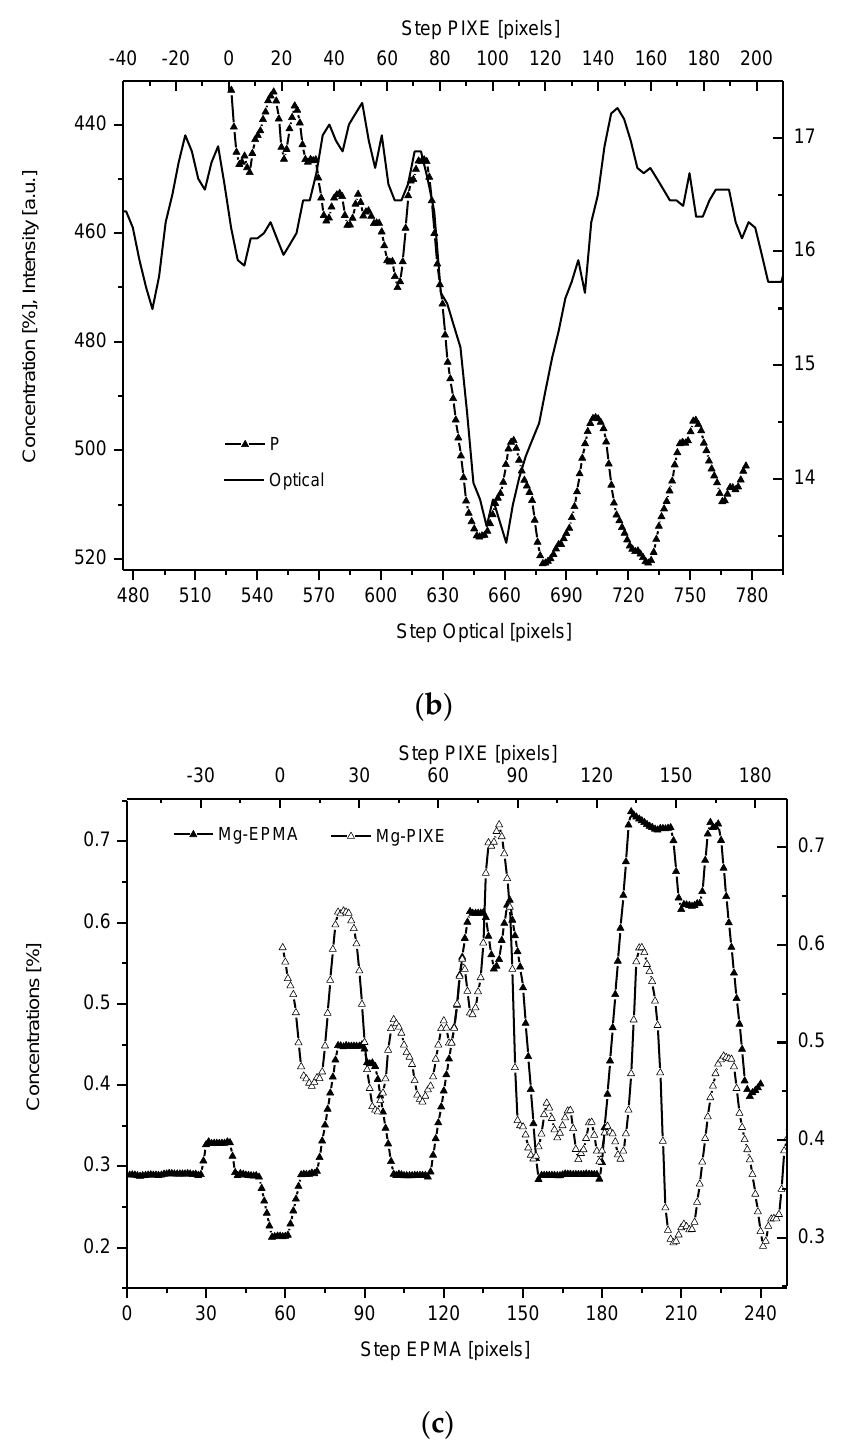
Figure 2. ( a ) Results of µ-PIXE measurements. 1 step = 1.25 µm. ( b ) Outline of the DEJ space with optical signal and with P signal, for left boundary only; please observe missing boundary DEJ-dentin due to the air path of measurements and inability of detection of carbon. ( c ) Parallelism of Mg measurements with the use of EPMA and µ-PIXE.